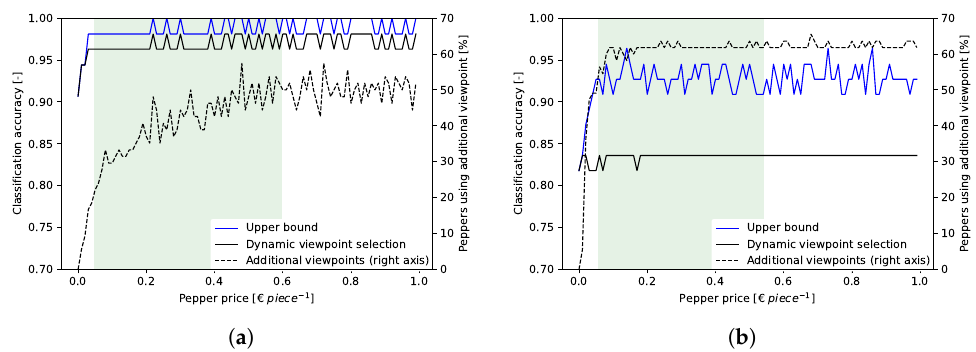
Figure 8. Influence of the pepper price on the average number of viewpoints and the classification accuracy for the red ( a ) and yellow ( b ) peppers. The green area indicates the range of sweet pepper market prices of 2019 as mentioned in Section